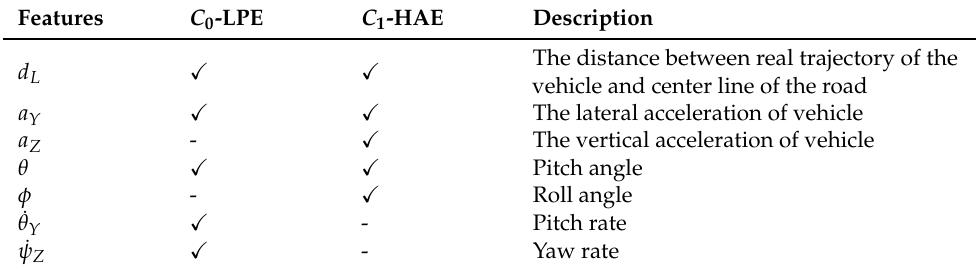
Table 2. Final Feature Selection for each target.